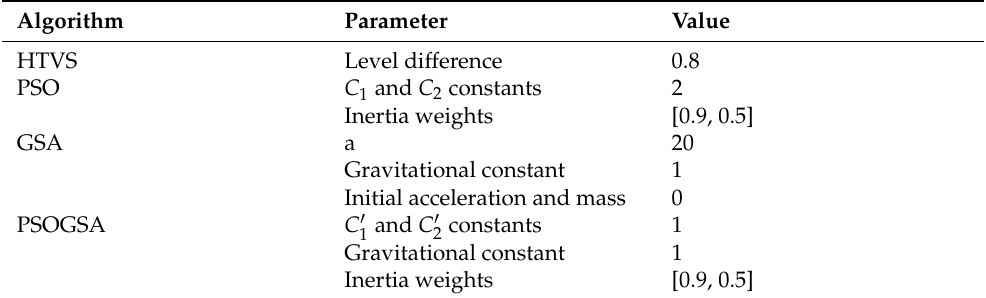
Table 4. Special parameters for each